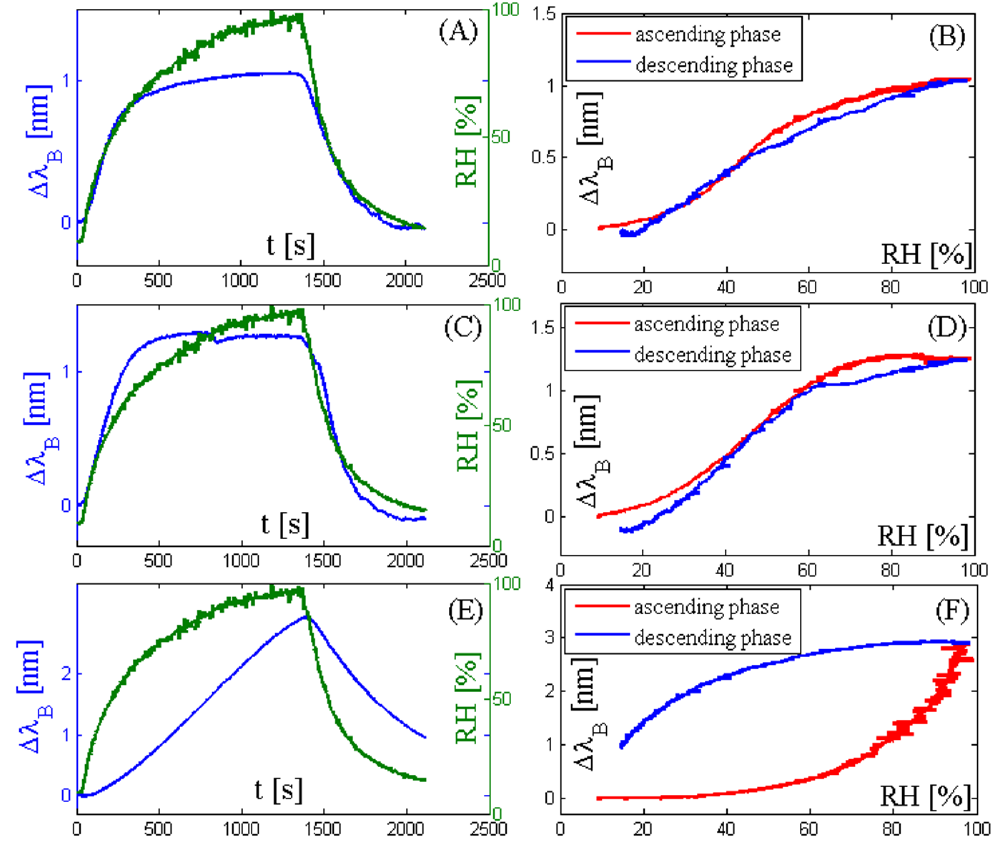
Figure 4. ( A ) RH trend during the cycle (green line) and corresponding Bragg wavelength shift of the sensor output (blue line) coated by agarose (3 mm × 3 mm); ( B ) Bragg wavelength shift of the sensor output coated by agarose (3 mm × 3 mm) vs. the RH values during both the ascending phase (red line) and descending phase (blue line); ( C ) RH trend during the cycle (green line) and corresponding Bragg wavelength shift of the sensor output (blue line) coated by agar (3 mm × 3 mm); ( D ) Bragg wavelength shift of the sensor output coated by agar (3 mm × 3 mm) vs. the RH values during both the ascending phase (red line) and descending phase (blue line); ( E ) RH trend during the cycle (green line) and corresponding Bragg wavelength shift of the sensor output (blue line) coated by agar (5 mm × 5 mm); ( F ) Bragg wavelength shift of the sensor output coated by agar (5 mm × 5 mm) vs. the RH values during both the ascending phase (red line) and descending phase (blue line).